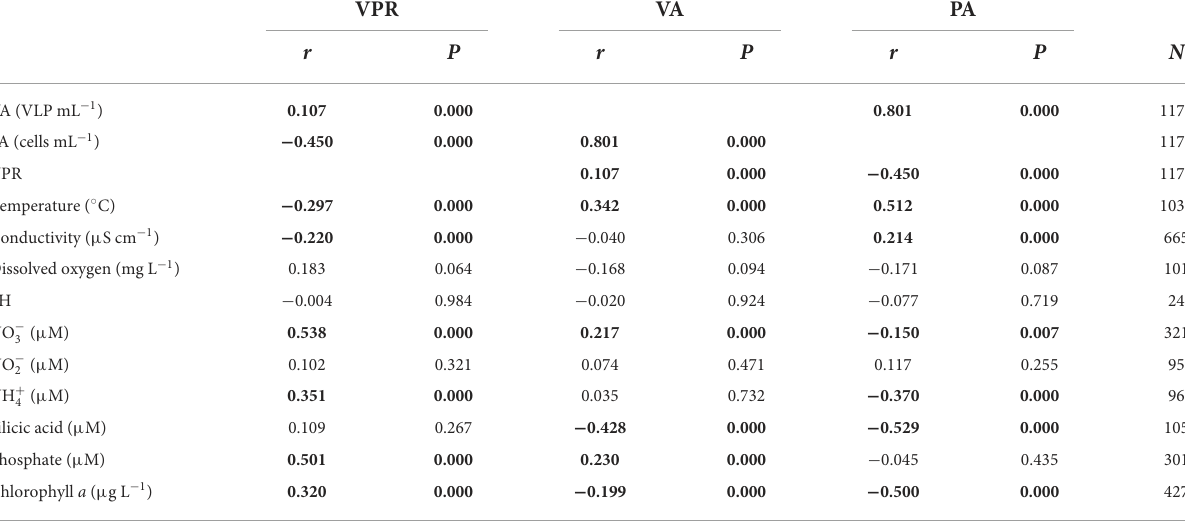
TABLE 3 Spearman’s rank correlations (r) between viral and prokaryotic abundance, VPR and environmental variables in all studied ecosystems of South hemisphere.